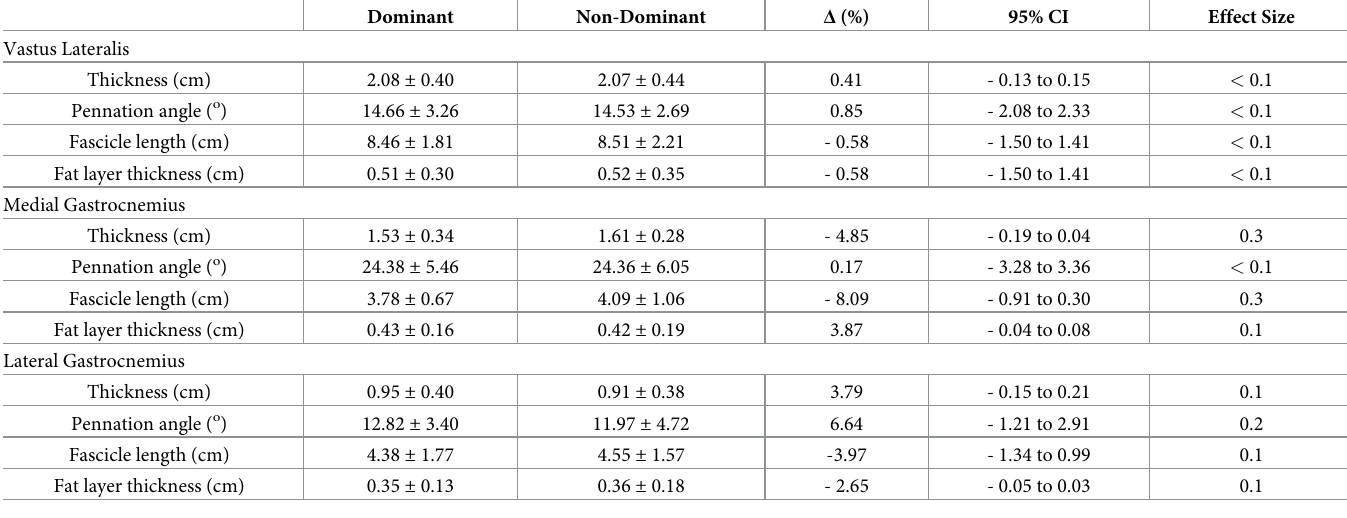
Table 1. Muscle architecture variables.